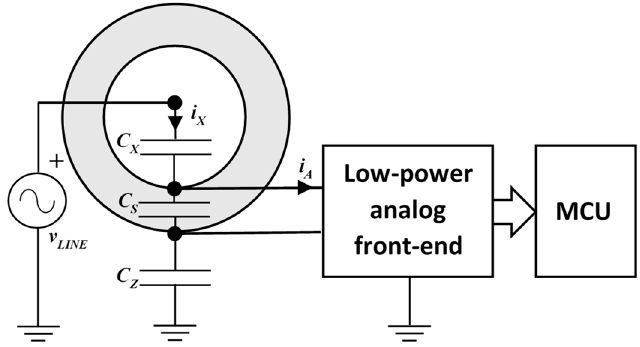
Figure 1. Scheme of the low-power contactless voltage measurement system.